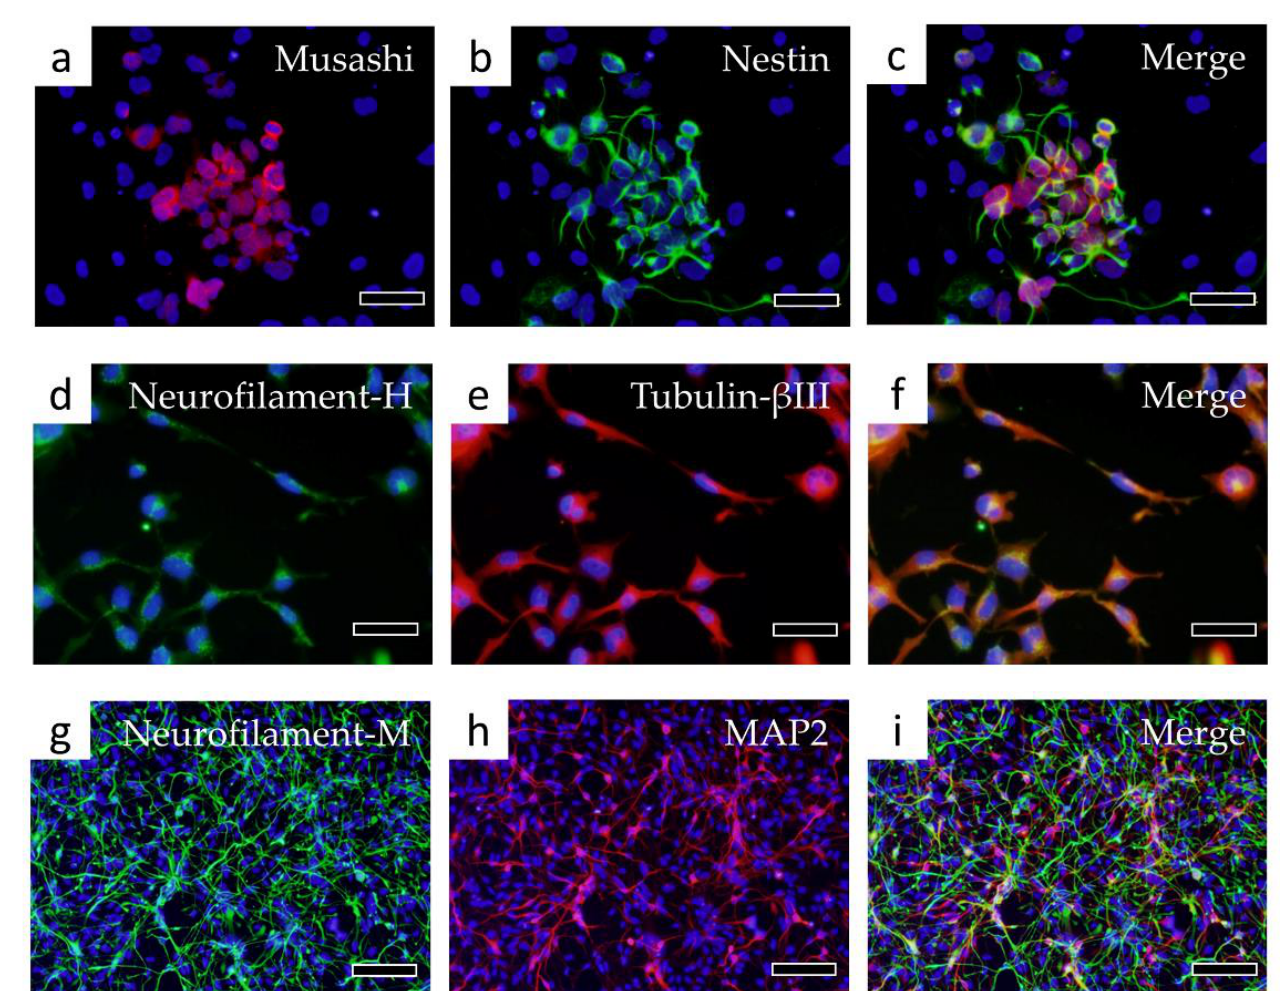
Figure 6. Immunostaining of cells differentiated into nerve cells. Fluorescent immunostaining was performed with the following markers of neural stem/progenitor cells: ( a ) Musashi, ( b ) Nestin, ( c ) Merge of Musashi and Nestin. Immunostaining was then performed with the following markers of nerve cells: ( d ) Neurofilament-H, ( e ) Tubulin-βIII, ( f ) Merge of Neurofilament-H and Tubulin-βIII, ( g ) Neurofilament-M, ( h ) MAP2, ( i ) Merge of Neurofilament-M and MAP2. Bars in panels ( a – f ): 50 μm, bars in panels ( g – i ): 100 μm.